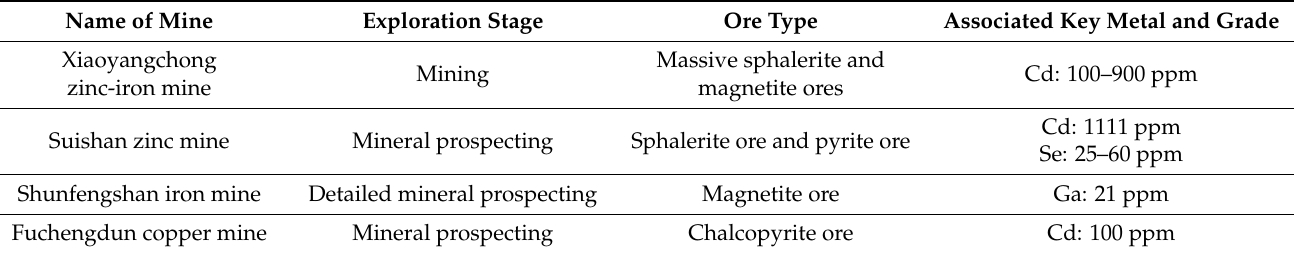
Table 3. Key metals associated with important deposits in the FVB